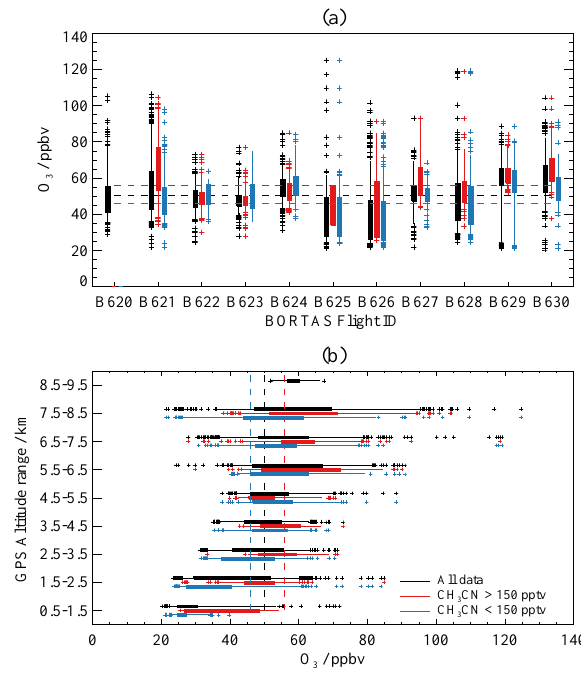
Fig. 3. Box and whisker plots showing the statistical distribution of O 3 measurements made from the BAe-146 during BORTAS as a BORTAS as a function of (a) research flight (see Table 1 and Palmer et al. (2013)), and (b) aircraft GPS altitude. In both plots solid boxes show the range of the 25th to 75th percentiles and whiskers show the range of the 5th to 95th function of (a) research flight (see Table 1 and Palmer et al., 2013), percentileswithoutliersshownasplussymbols. Blackboxesandwhiskersshowallmeasuredvalues,redboxesand and (b) aircraft GPS altitude. In both plots solid boxes show the whiskers show plume measurements determined from measured CH 3 CN mixing ratios in excess of 150 pptv, and range of the 25th to 75th percentiles and whiskers show the range blueboxesandwhiskersshownon-plumemeasurements(i.e.CH 3 CNlessthan150pptv). Dashedlinesineachpanel indicatethecampaignmeanO 3 mixingratioforeachgroupofdatapoints. of the 5th to 95th percentiles with outliers shown as plus symbols. Black boxes and whiskers show all measured values, red boxes and whiskers show plume measurements determined from mea- sured CH 3 CN mixing ratios in excess of 150pptv, and blue boxes and whiskers show non-plume measurements (i.e. CH 3 CN less than 150pptv). Dashed lines in each panel indicate the campaign mean O 3 mixing ratio for each group of data